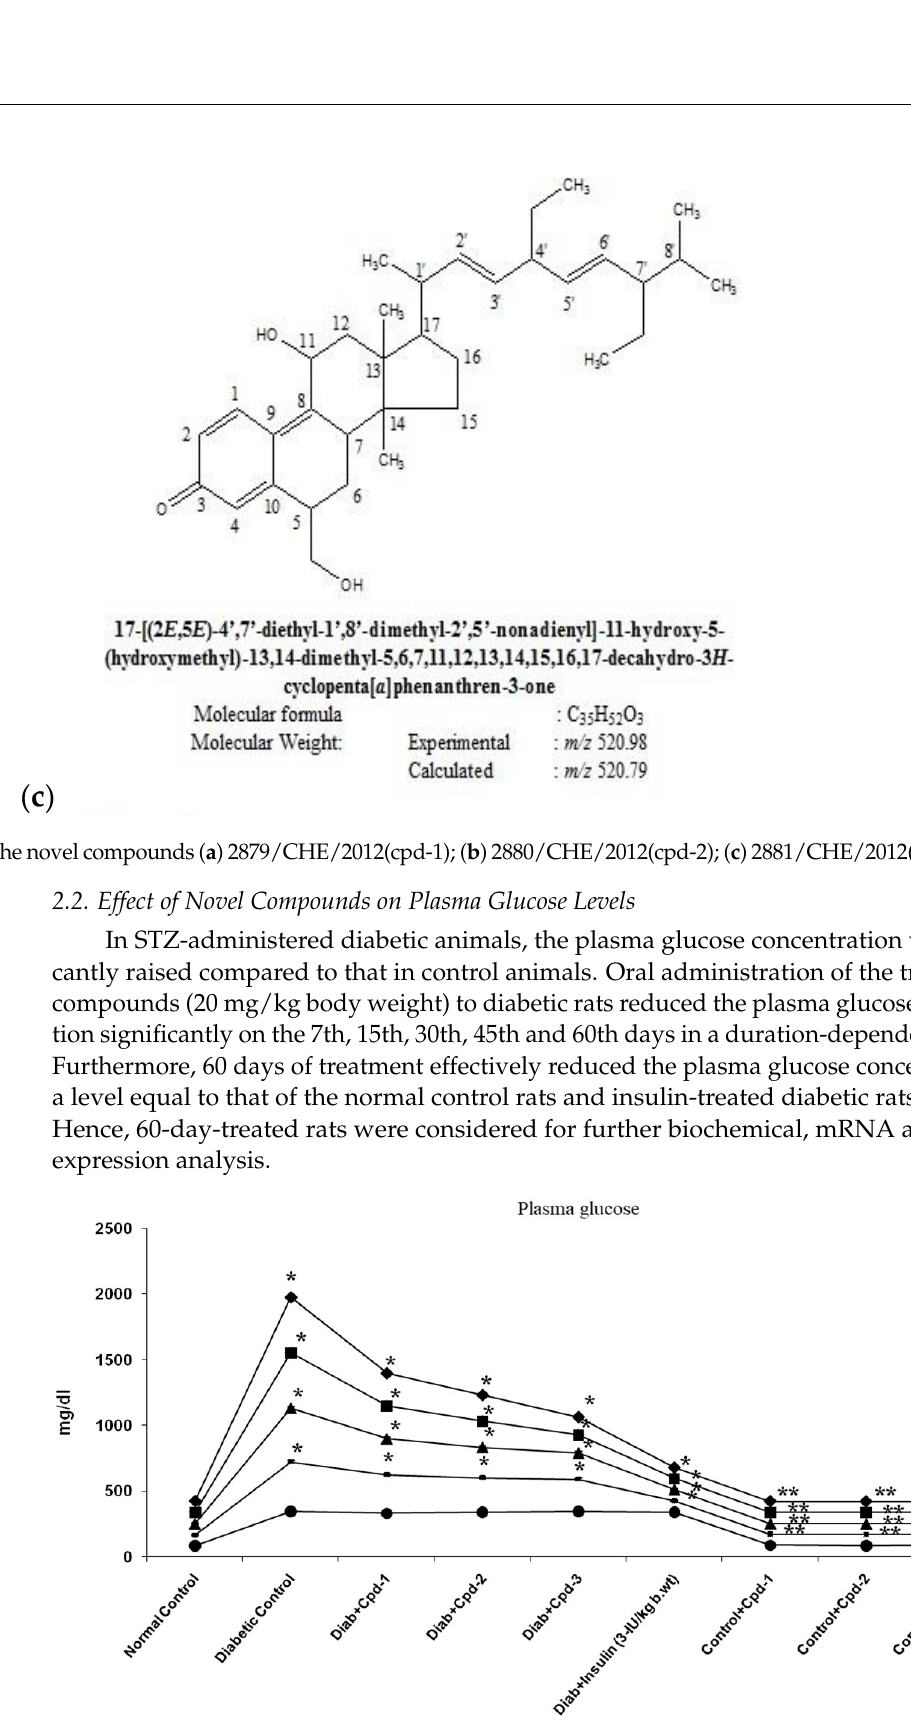
Figure 2. Effect of novel triterpenoids on plasma glucose in STZ-induced diabetic rats compared with the effect of insulin. Each bar represents Mean ± SEM of 6 animals. Significance at p < 0.05; *, compared with control; **, compared with diabetic control.